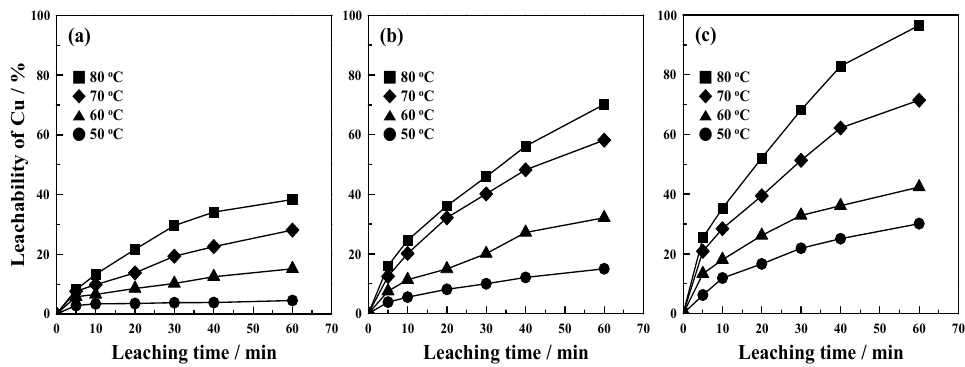
Figure 4. Leachability of Cu with the change of temperature from 50 to 80 °C (1 M HNO 3 , slurry density 10 g/L, stirring speed 300 rpm): ( a ) CuS as-received; ( b ) CuS ground at 300 rpm for 15 min; and ( c ) CuS ground at 700 rpm for 15 min.